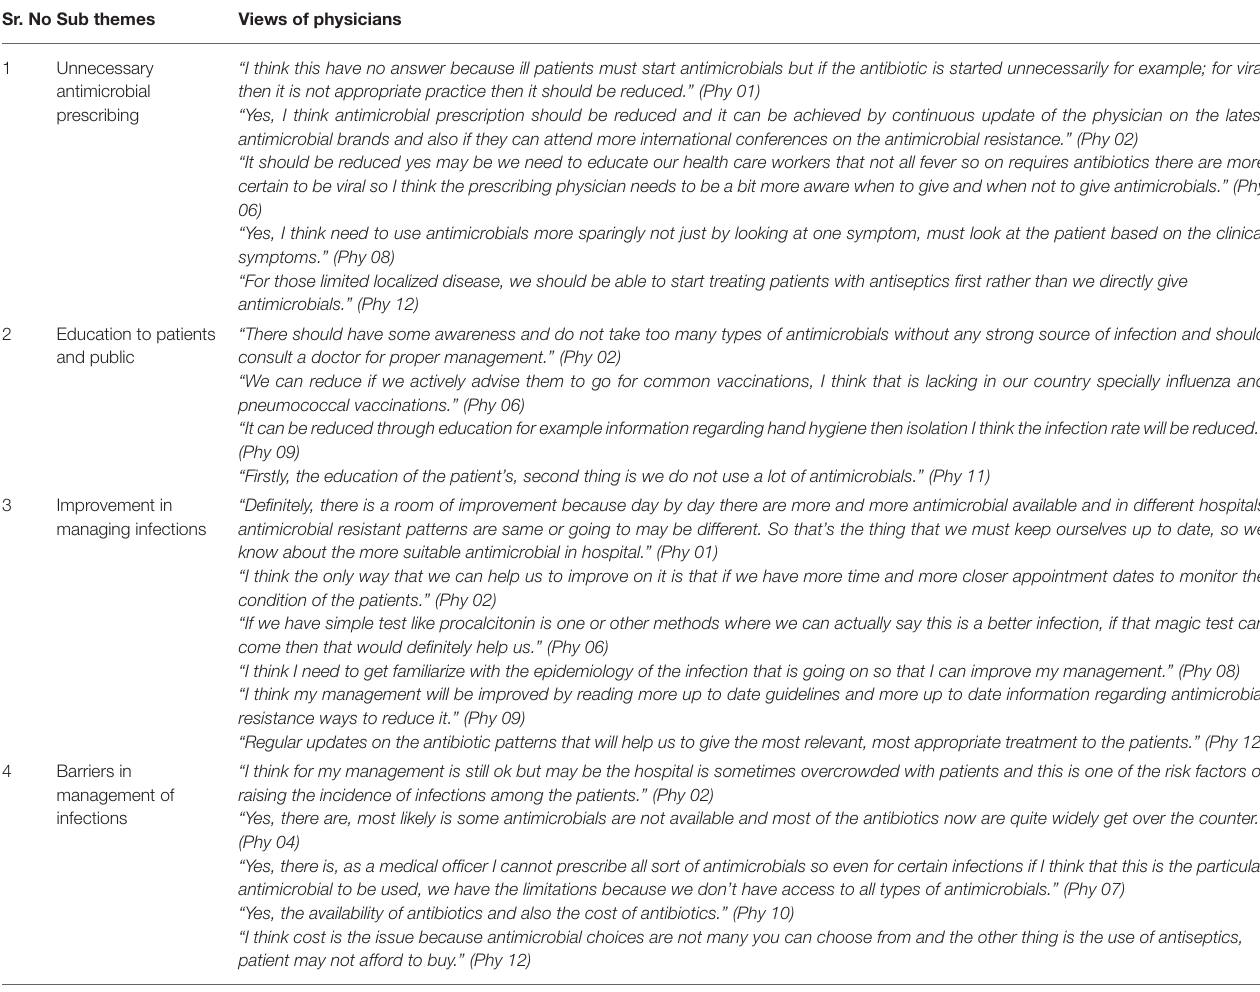
TABLE 3 | Physician’s infection management satisfaction. Sr. No Sub themes Views of